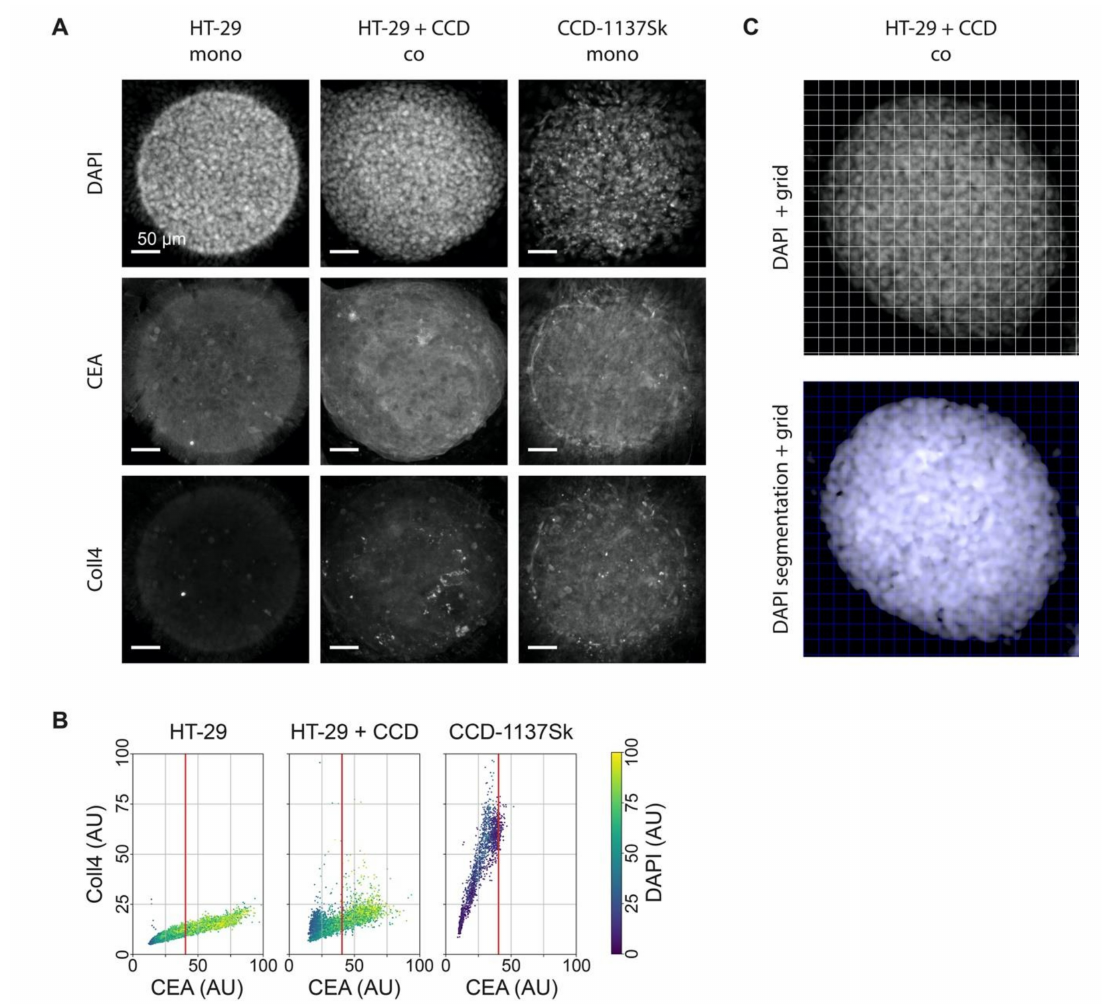
Figure 6. DAPI, CEA, and Coll4 staining jointly discriminate HT-29 and CCD-1137Sk cell populations in 3-D Dynarray co-cultures. A total of 4000 cells per chip cavity were seeded to yield either mono- or co-cultures of HT-29 and CCD-1137Sk cells. In case of co-cultures, 2000 HT-29 cells were co-seeded with 2000 CCD-1137Sk cells per well. After four days, chips were fixed, cleared, and stained with DAPI and antibodies against CEA and Coll4 as markers for nuclei, cancer cells, and fibroblasts, respectively. Subsequently, samples were imaged with 3-Dconfocal microscopy. ( A ) Representative sum-z projections. ( B ) Scatter plots showing the anti-Coll4 intensity distribution as a function of the anti-CEA intensity for HT-29 mono-cultures (left), HT-29 + CCD-1137Sk co-cultures (middle), and CCD-1137Sk mono-cultures (right). Each dot shows the average intensity of voxel cubes in a total of five Dynarray cavities. Red vertical line, CEA brightness range that contains 95% of all CCD-1137Sk voxel cubes in mono-culture. ( C ) Exemplary images showing the voxel-cube grid used for the quantification of the average fluorescence intensities. Upper panel, raw sum-z projection of DAPI signal; lower panel, sum-z projection upon nuclei segmentation and background